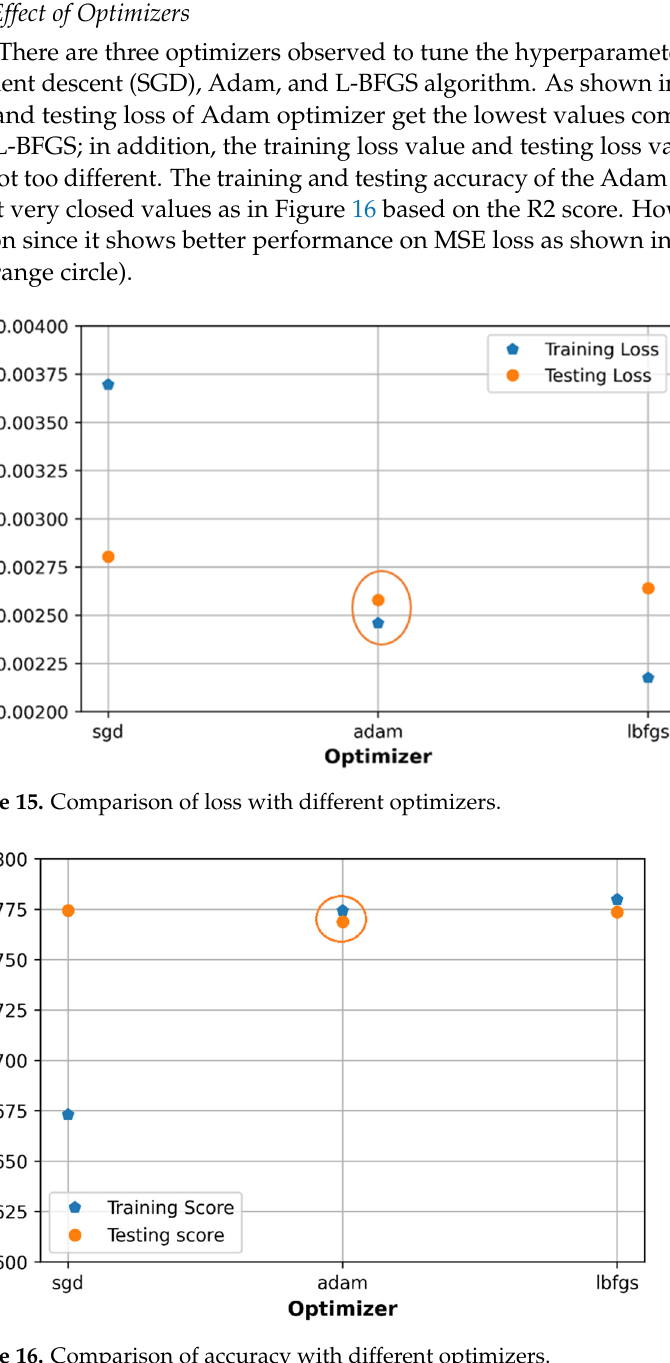
Figure 16. Comparison of accuracy with different optimizers.